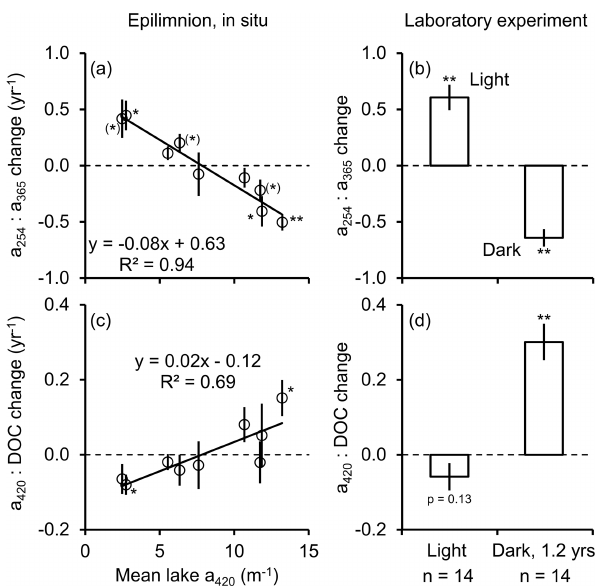
Figure 3. Changes in DOC quality over time as indicated by the op- tical indices A 254 : A 365 (unitless) and a 420 :DOC (m − 1 :mgL − 1 ) , shown separately for (a–b) the lake epilimnia and (c–d) laboratory experiments. In (a–b) , the y axis value of each symbol ( ± error bar) shows the linear slope ( ± standard error) of A 254 : A 365 or a 420 :DOC as a function of the water transit time in a certain lake. Symbols with asterisks represent individual changes (in situ data regression slopes; see Fig. 2) that are significant. The x axis values show mean absorbance ( a 420 ) of the lakes. Panels (c–d) show changes (stop minus start values; mean ± standard error) in A 254 : A 365 and a 420 :DOC during light ( ∼ 100MJ absorbed per m 3 of water) and dark (1.2 years) experiments performed on water from three of the study lakes. Bars with asterisks show changes that are significant (two-tailed paired t test comparing initial and ending conditions). Significance: ∗ p < 0 . 01; ∗∗ p < 0 . 001; ( ∗ ) marginally significant p < 0 . 05. See Table 1 for sample numbers and descrip- tions of each